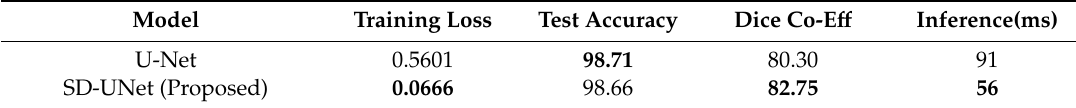
Table 3. Performance comparison between U-Net and SD-UNet.